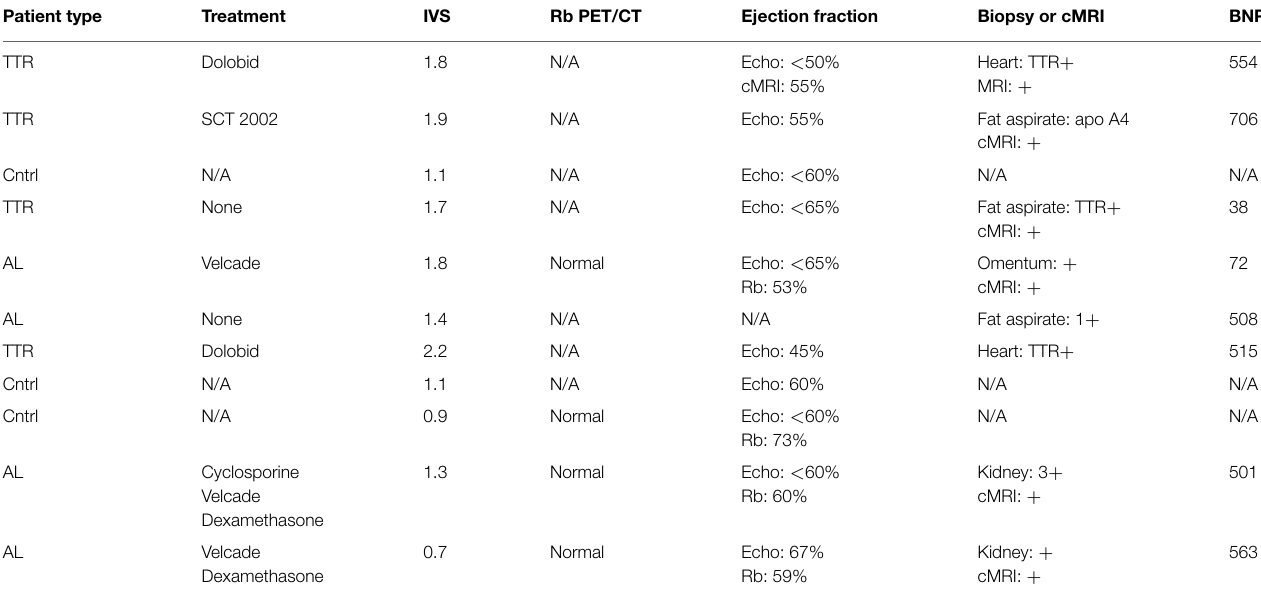
TABLE 1 | Patient data for amyloid positive and healthy controls . Patient type